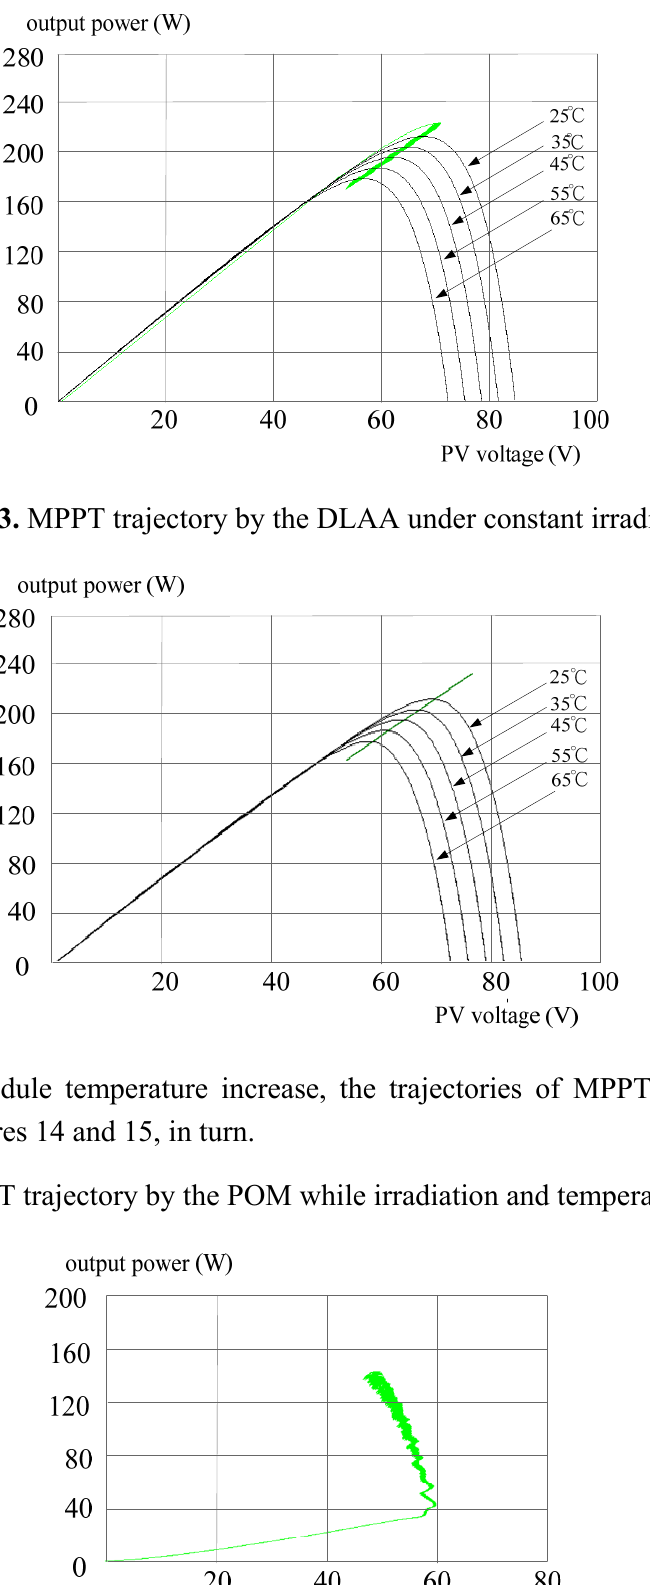
Figure 12. The MPPT trajectory by the POM under constant irradiation.